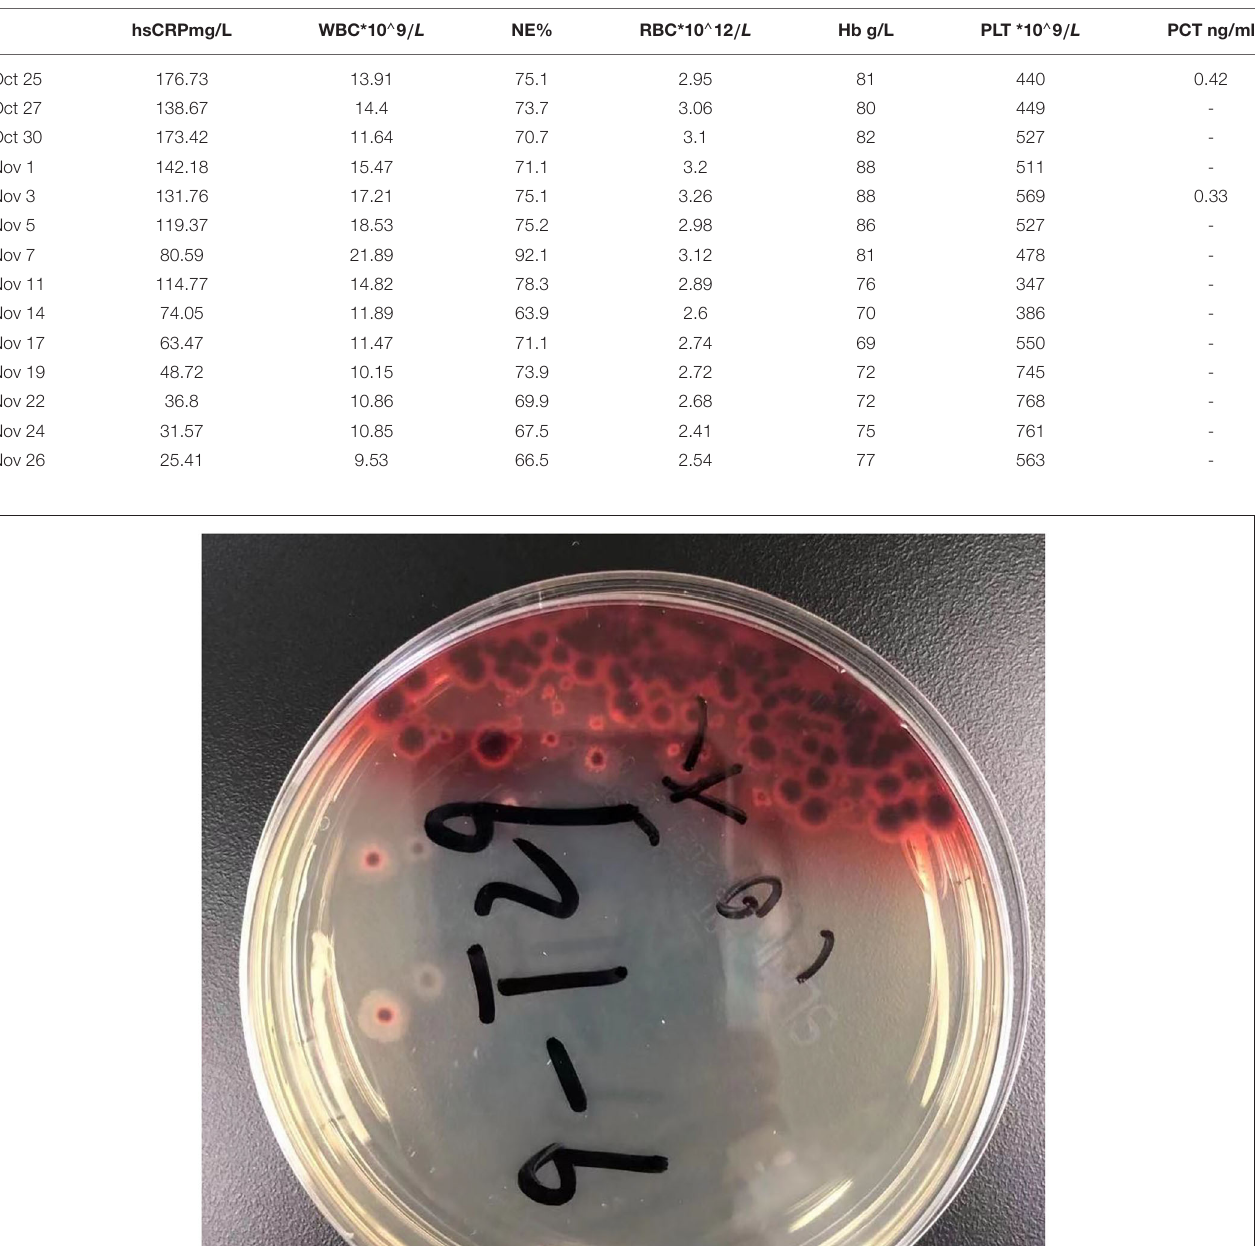
( Figure 2 ), and the inflammation indexes did not improve ( Table 3 ). During hospitalization, his galactomannan (GM) was positive in serum. Thus, we empirically add caspofungin for